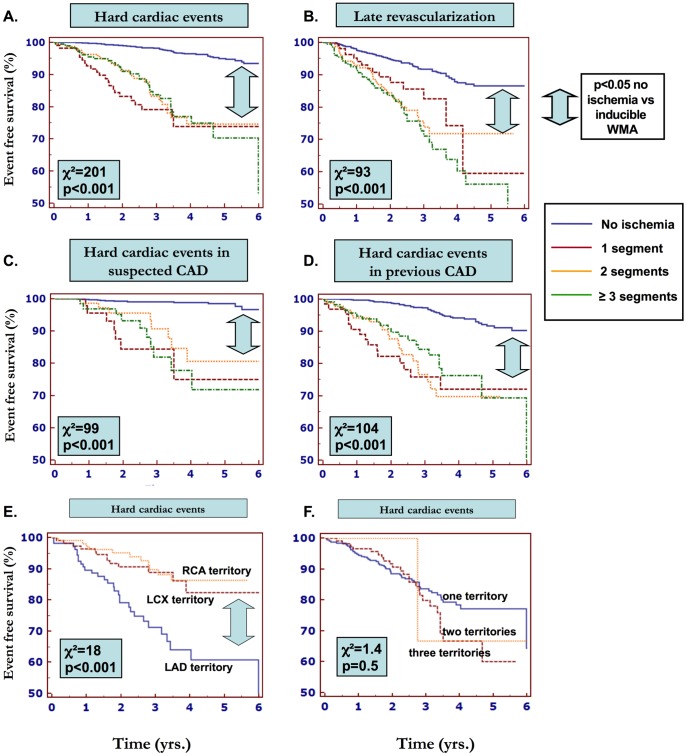
Survival analysis in patients with known or suspected CAD undergoing dobutamine stress CMR.In patients that exhibited dobutamine induced ischemia, the extent of ischemia did not influence hard cardiac events (A) and revascularization procedures (B). The threshold of 1 ischemic segment was enough to predict a poor outcome irrespective of the absence (C) or presence (D) of known CAD. Significantly more hard cardiac events were seen in patients with LAD-territory related ischemia (E). Extension of ischemia to more than one coronary territory did not influence the rate of hard cardiac events (F).